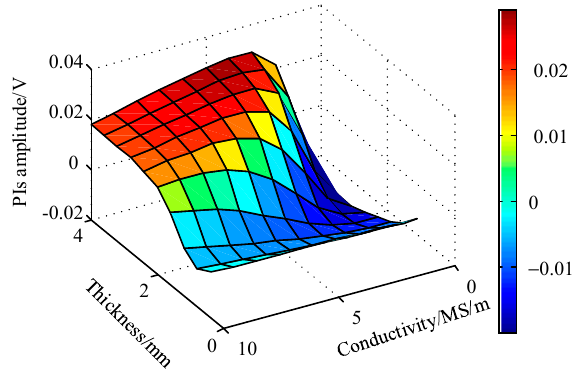
Figure 10. PIs time change with thickness and conductivity.